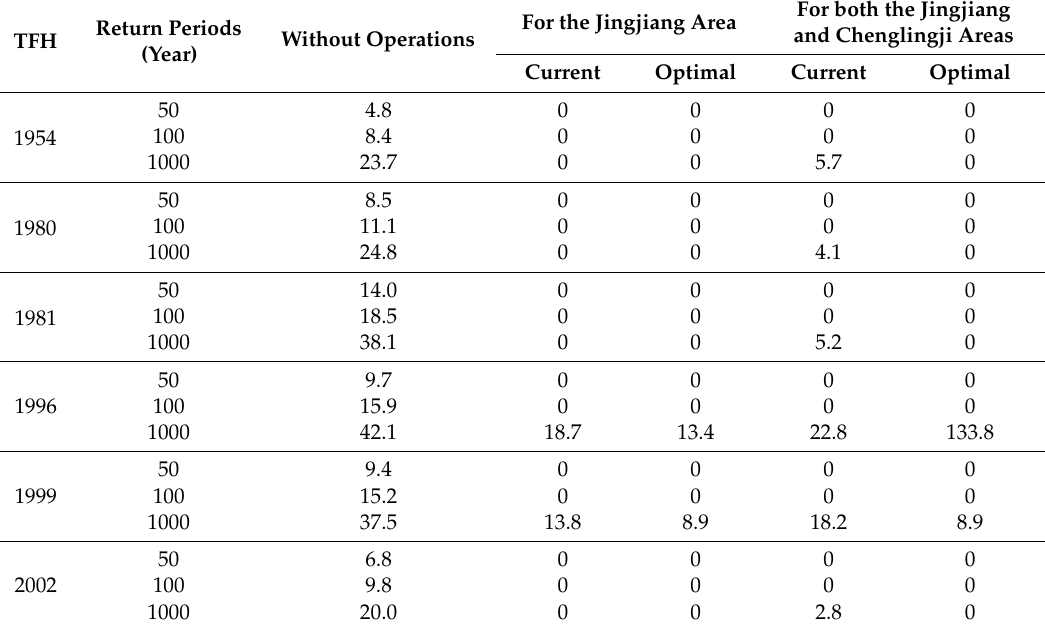
Table 8. Flood diversion volumes of some design flood hydrographs at the Jingjiang flood control point (billion m 3 ).